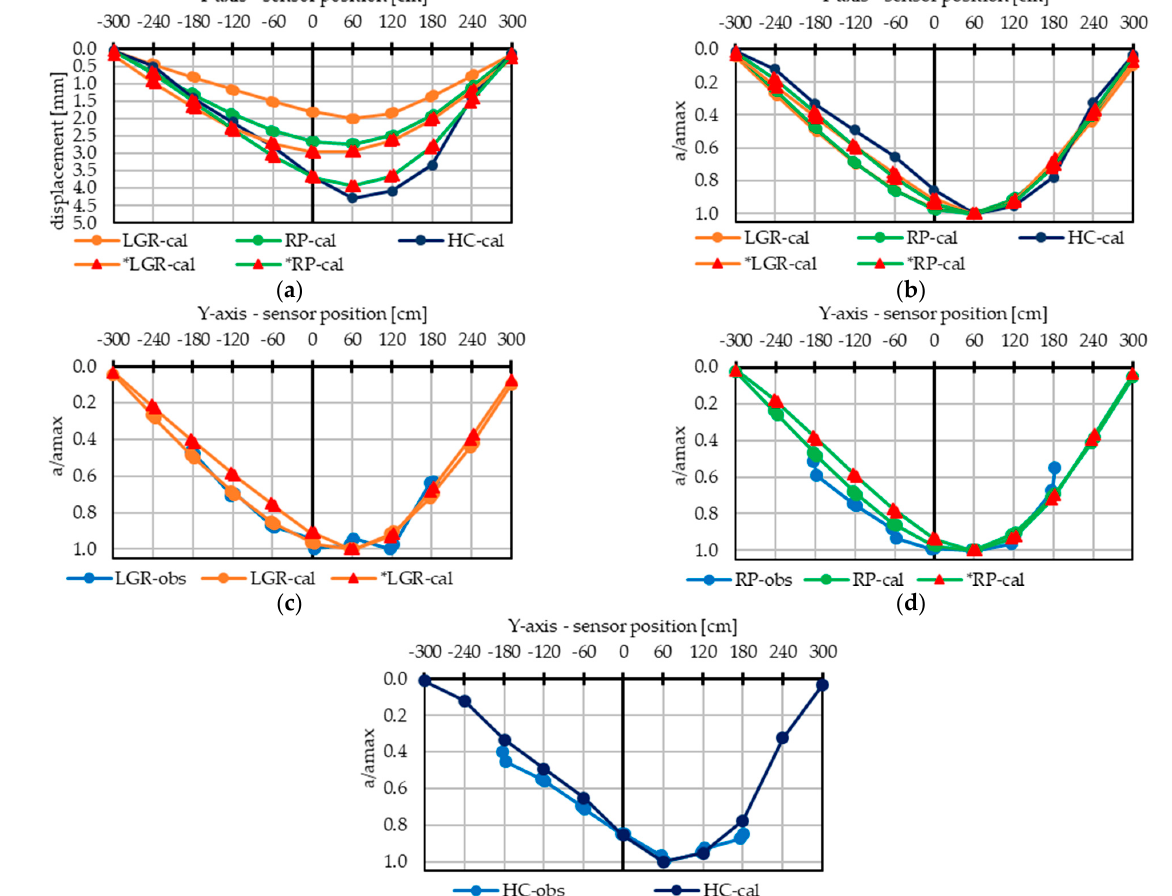
Figure 23. Comparisons of the displacement in the Y-axis between FEM calculation and short-term measurements: ( a ) calculated displacement; ( b ) calculated performance of panels at Y-axis; ( c ) LGR performance; ( d ) RP performance; ( e ) HC panels performance. obs—observed deflection, cal—deflection with a thickness h red caused by short-term loading, *cal—deflection with a thickness *h red caused by short-term loading.